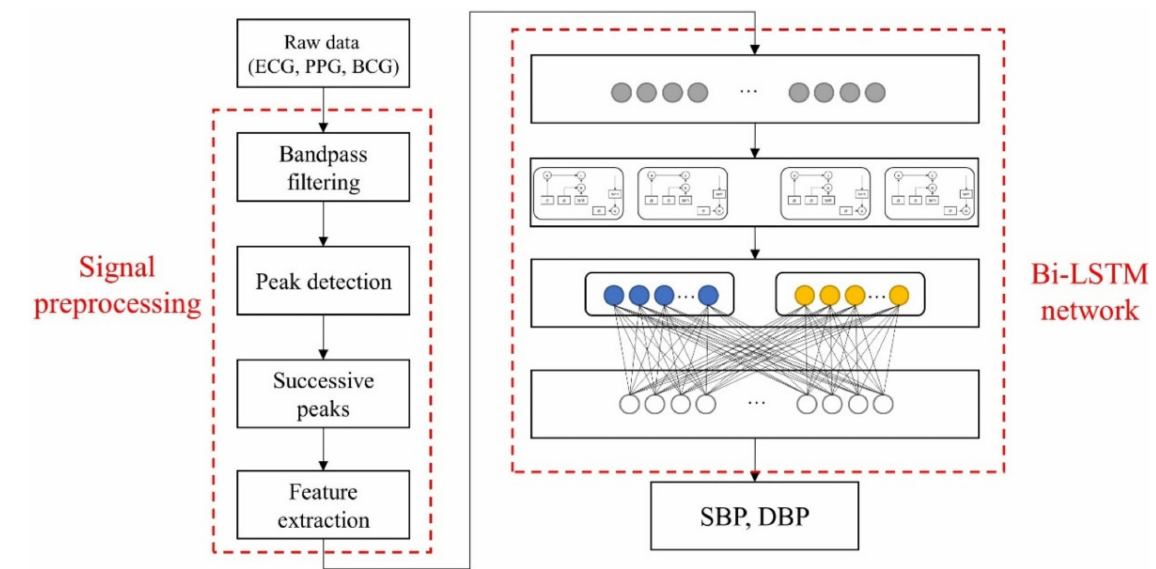
Figure 1. Overview of proposed